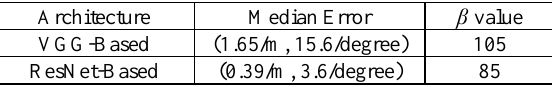
Table 1. Test results with synthetic range images